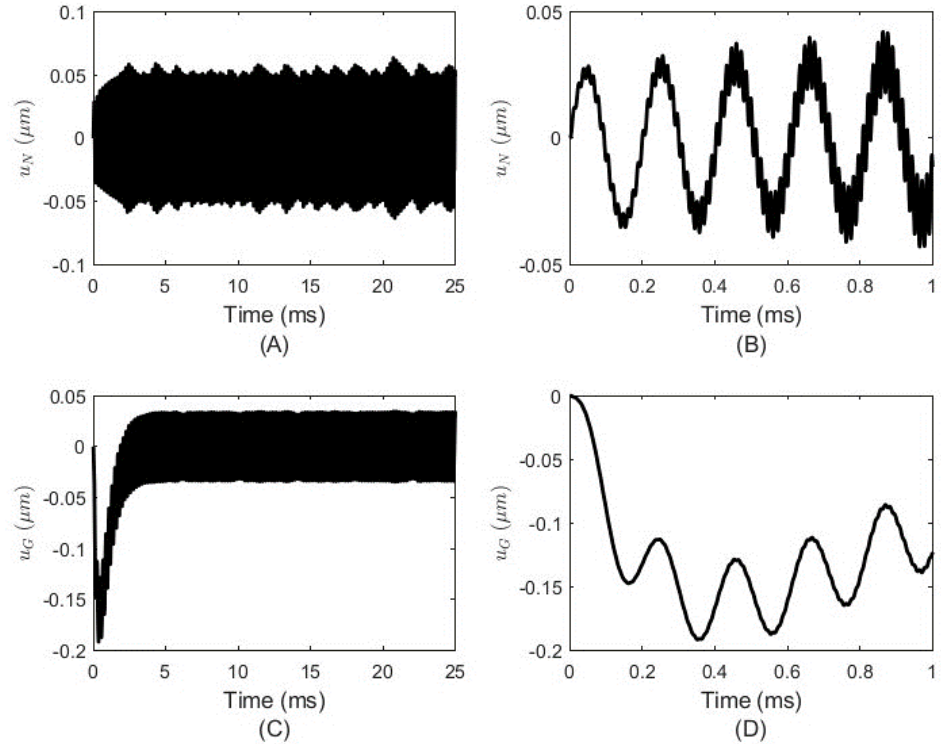
Figure 8. Results for the brain-on-a-chip with one glia’s endfoot in the case of dynamic synthesis of NO: (A) neuronal displacement 𝒖